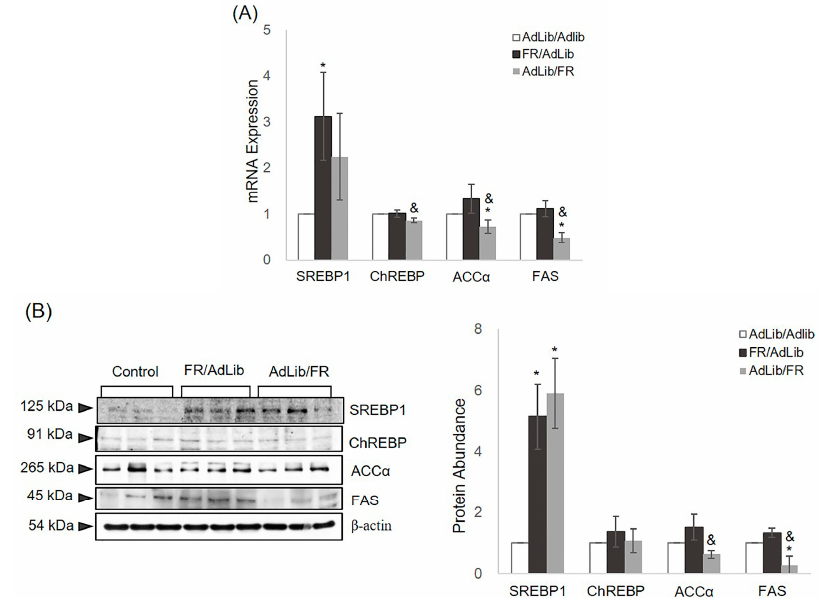
Figure 3. Relative mRNA and protein levels of hepatic lipid metabolism-related genes in three-week-old male offspring. ( A ) The levels of mRNAs encoding SREBP1, ChREBP, ACC α , and FAS were determined by real-time PCR in the three groups ( n = 9 control, n = 9 FR/AdLib, and n = 9 AdLib/FR). Each value was calculated using the ∆∆ C t method (the cycle threshold value method) normalized to that of GAPDH. Data are presented as means ± SDs; ( B ) the protein expression levels of SREBP1, ChREBP, ACC α , and FAS were measured by Western blotting in the three groups ( n = 9 control, n = 9 FR/AdLib, and n = 9 AdLib/FR). β -actin served as the reference protein for normalization of band intensities. Data are presented as means ± SDs. p- values indicate the significance of the differences among the groups (one-way ANOVA). * ( p < 0.05) vs. control, and & ( p < 0.05) vs. FR/AdLib or AdLib/FR. SREBP1,